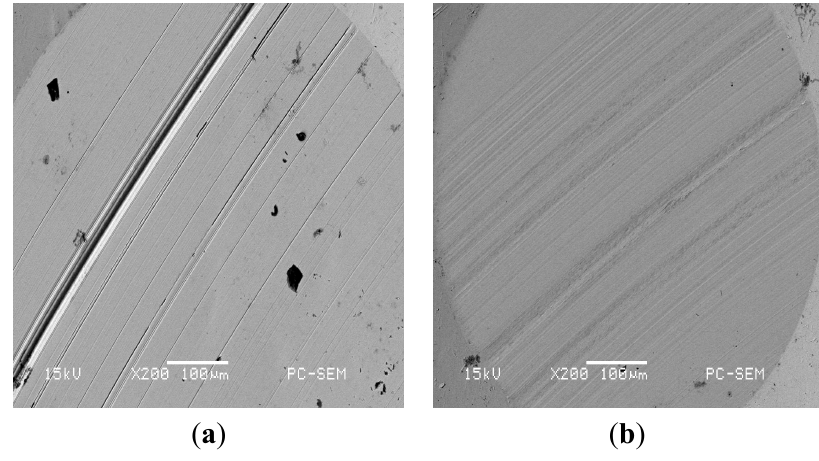
Figure 4. SEM image of the lubricant base stock with ( a ) EBD; ( b ) 2-EHBD.